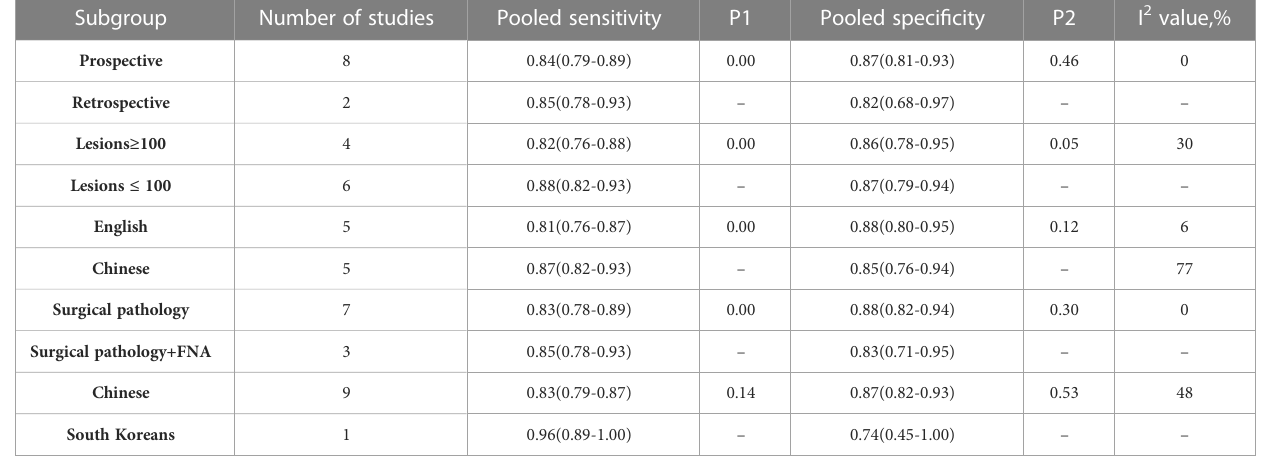
TABLE 4 Meta regression analysis